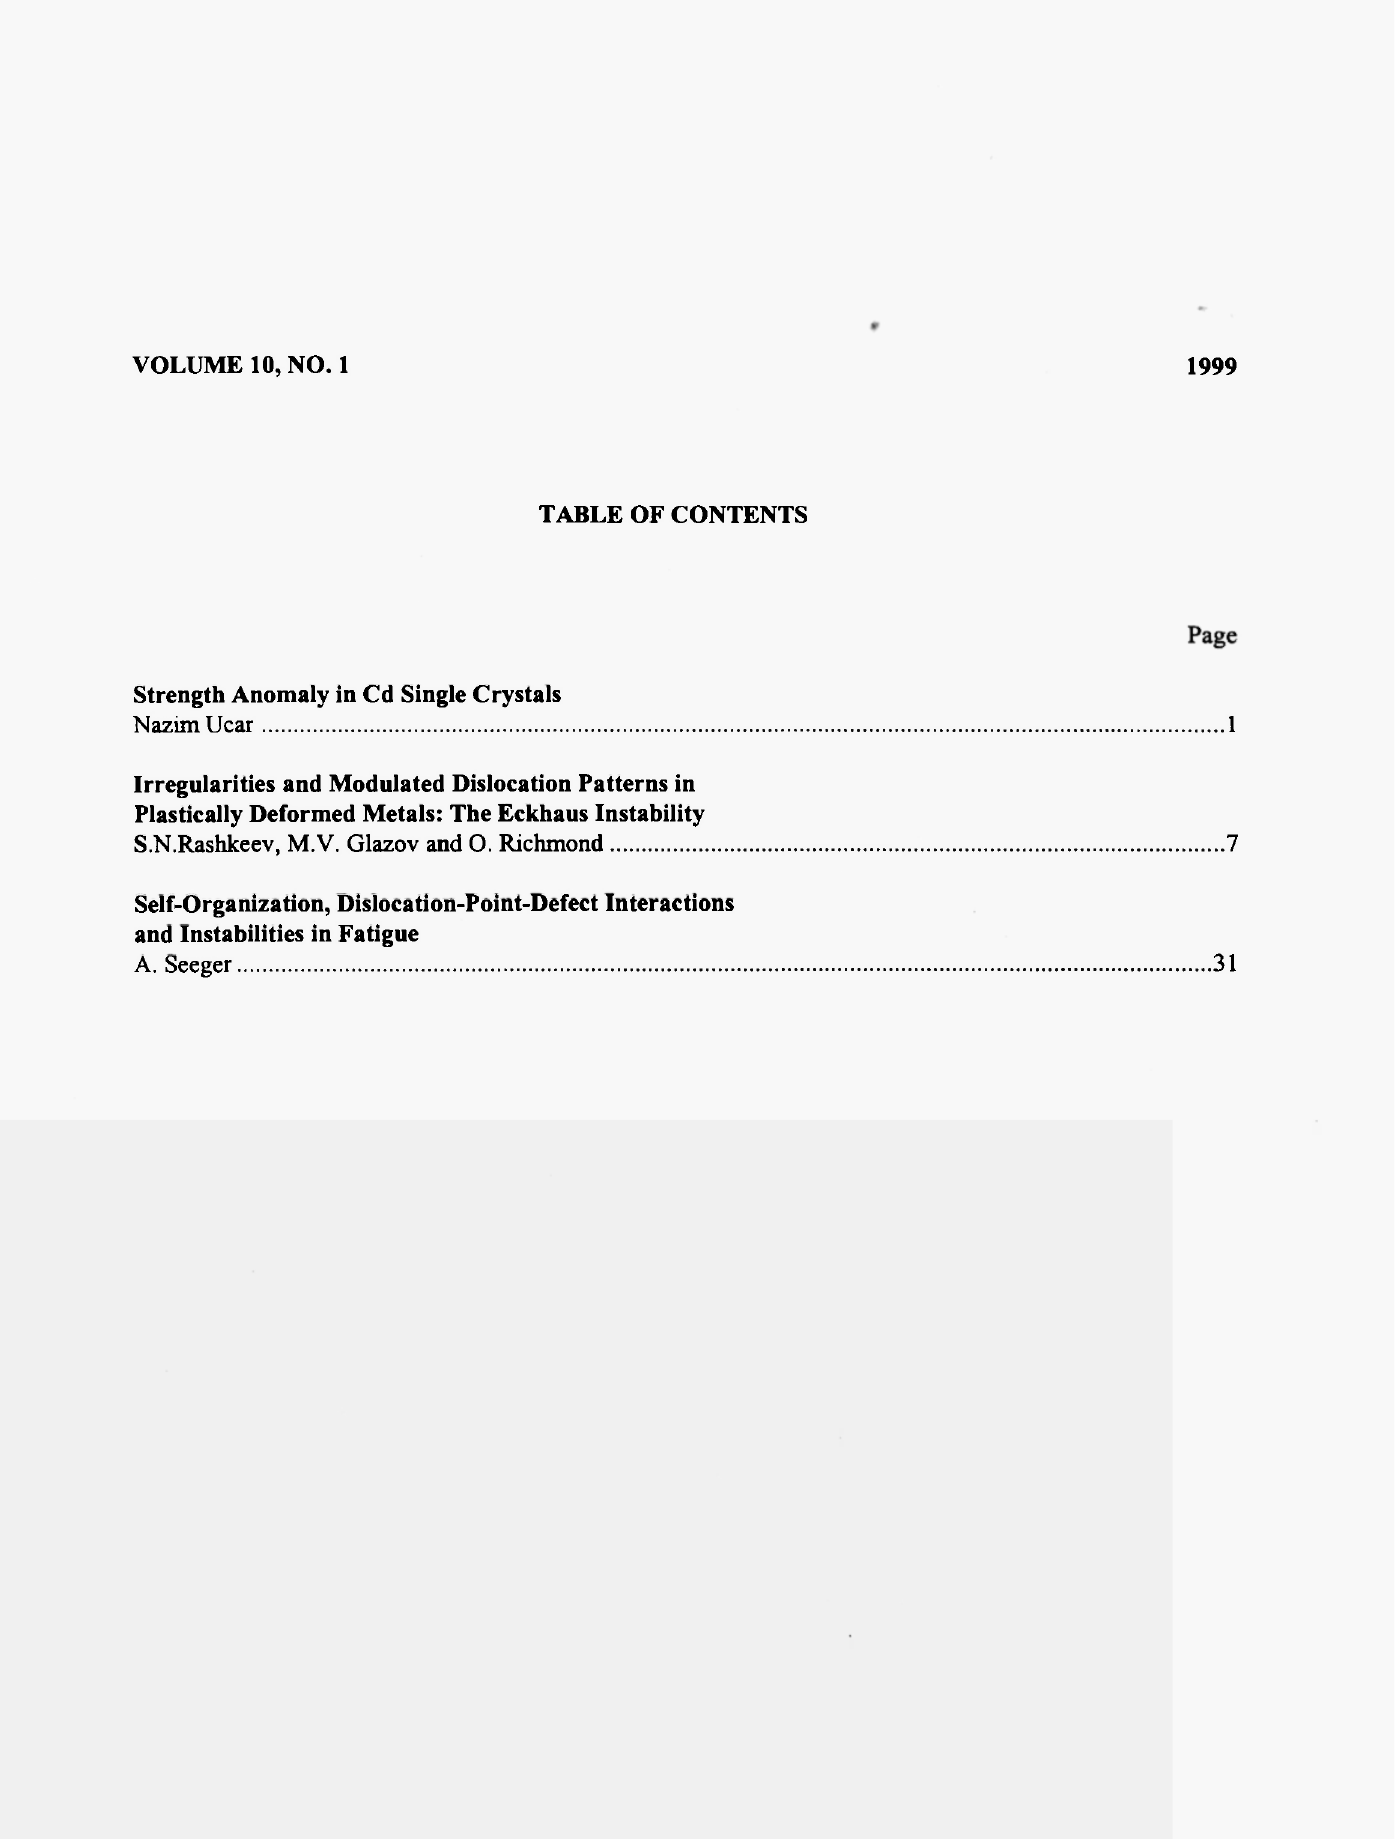
Strength Anomaly in Cd Single Crystals Nazim Ucar Irregularities and Modulated Dislocation Patterns